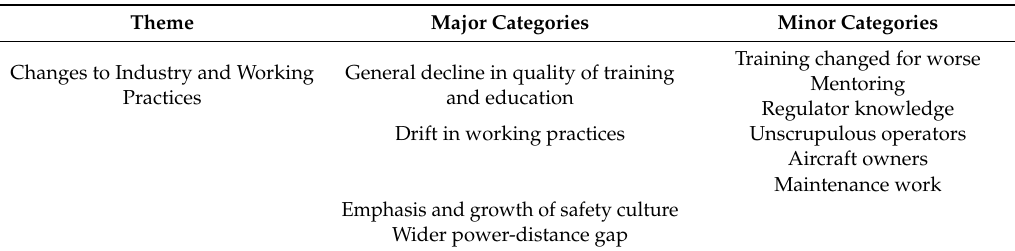
Table 3. Summary of findings for the Changes to Industry and Working Practices